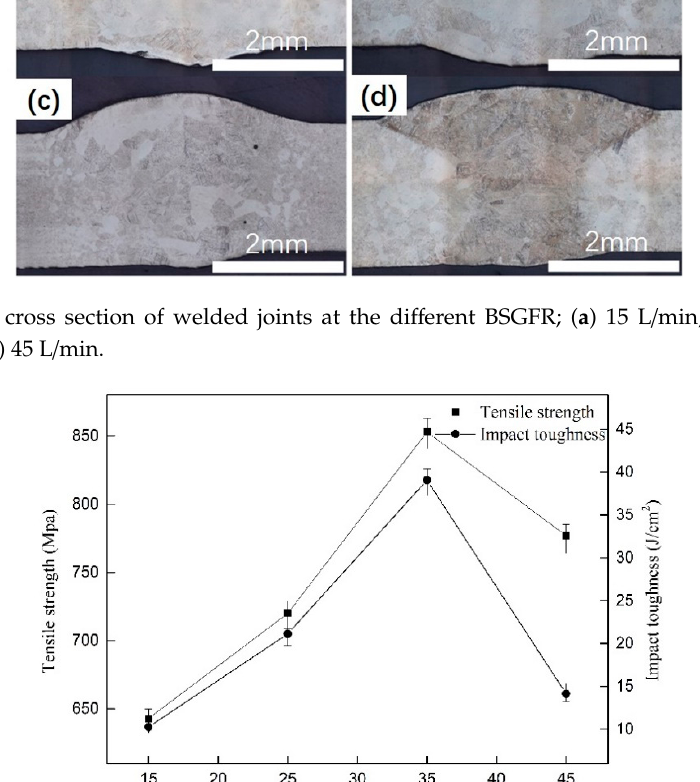
Figure 8. The e ff ect of the BSGFR on tensile strength as well as impact Figure 8. The effect of the BSGFR on tensile strength as well as impact toughness.